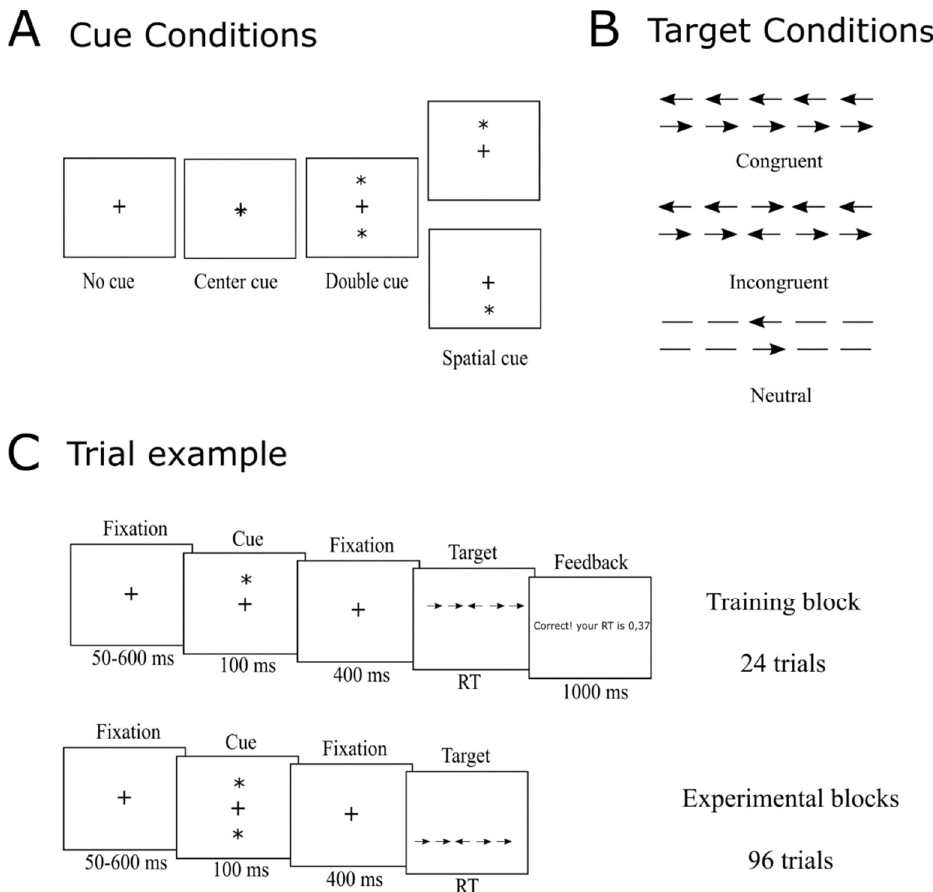
Figure 2. Overview of the ANT. ( A ) Cue conditions. ( B ) Target conditions. ( C ) Example of a training block trial (first row) and an experimental block trial (second row). * = cue, + = fixation cross, ← = arrow pointing left, → = arrow pointing right. Adapted from [19] ©2002 by the Massachusetts Institute of Technology. All rights